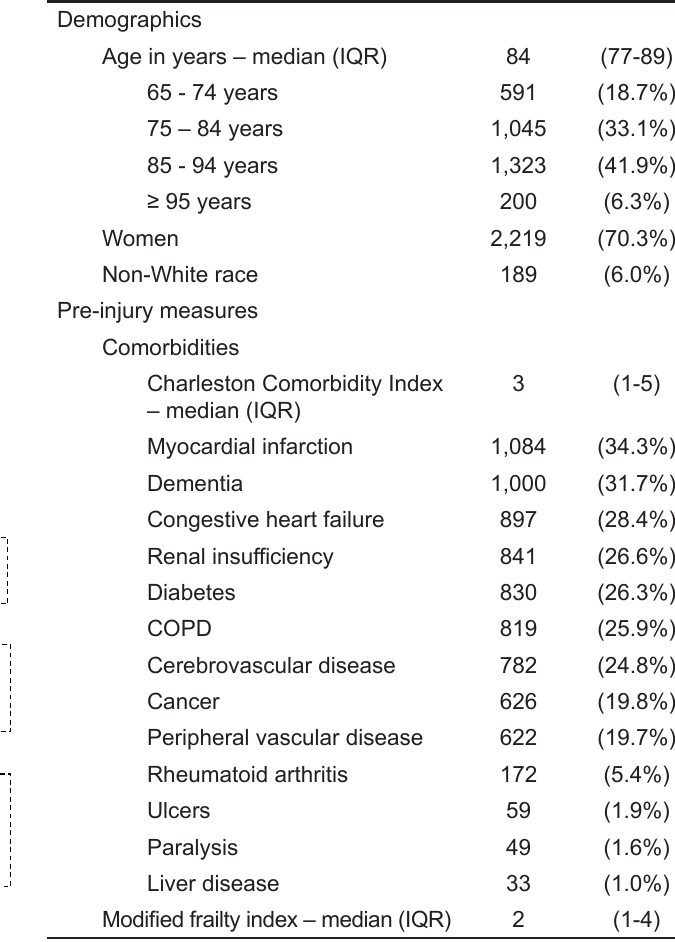
Table 1. Characteristics of community-dwelling older